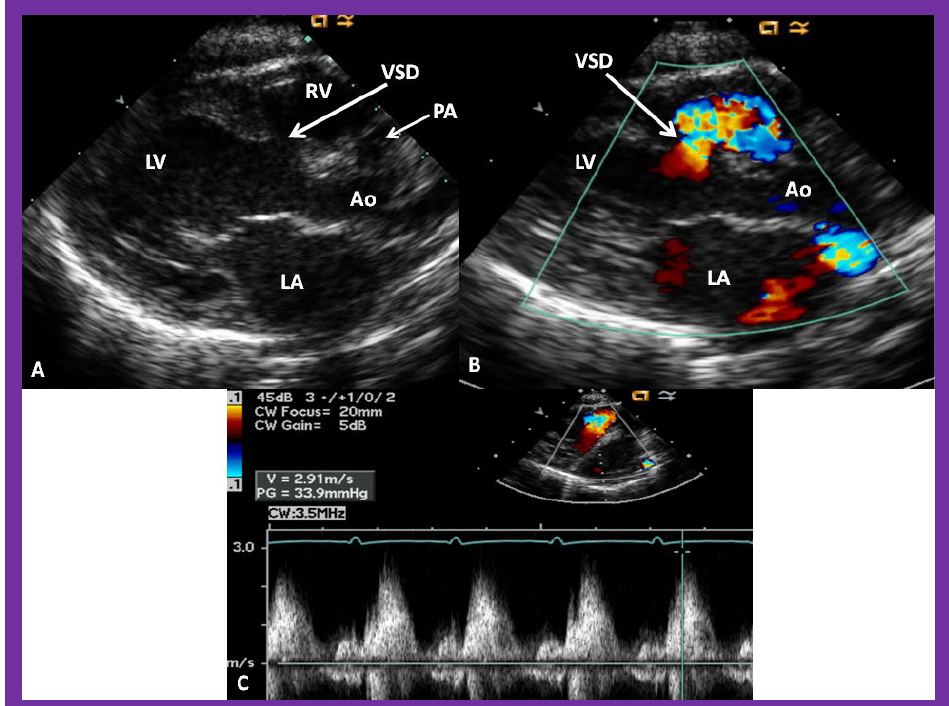
Figure 10. Selected video frames from parasternal long axis views of a patient with tricuspid atresia with normally related great arteries demonstrating an enlarged left atrium (LA) and left ventricle (LV), a small right ventricle (RV) and a moderate sized defect (VSD) (thick arrow) on 2D ( A ) and color flow ( B ) imaging. The turbulent flow ( B ), with a Doppler flow velocity of 2.91 m/s by continuous wave Doppler ( C ) across the VSD, suggests some restriction of the VSD. Ao, Aorta; PA, pulmonary artery. Reproduced from Reference [29].